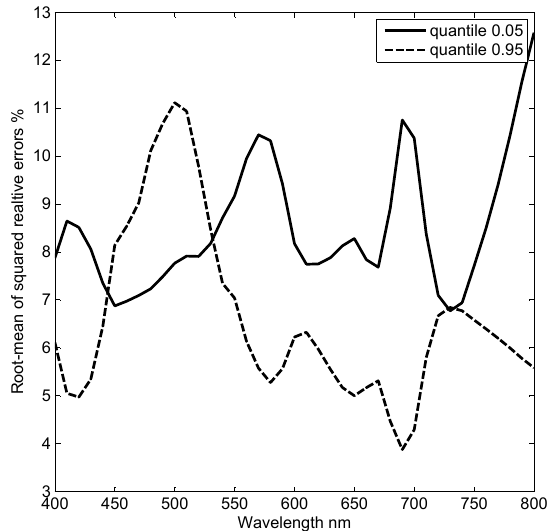
Figure 4. RMS-RE values in estimated σ as function of wavelength. The values of σ were derived from fluctuated mean and two field spectra corresponding to 0.05 and 0.95